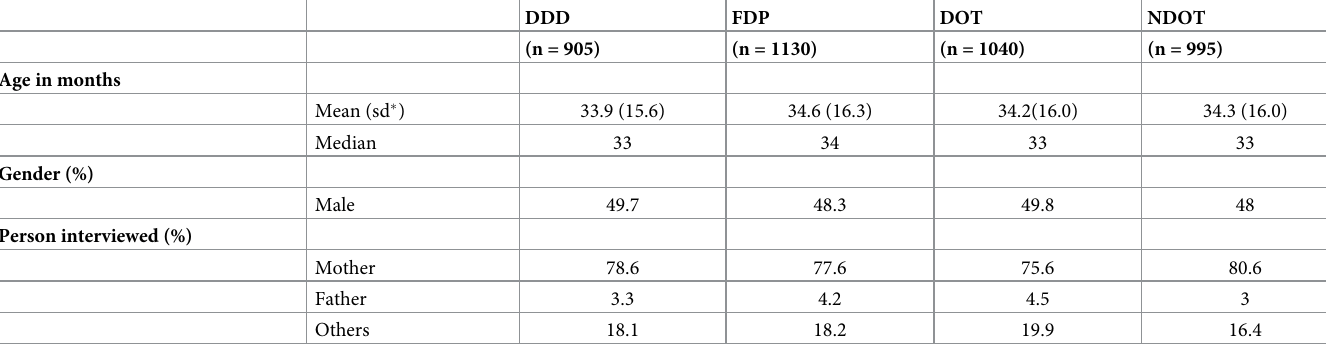
Table 1. Demographic characteristics by method of delivery and the type of observation of the